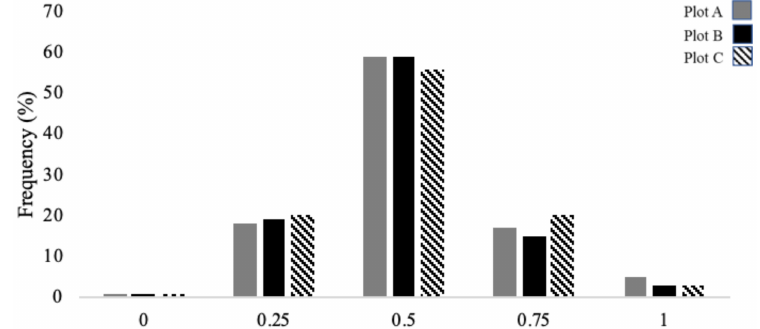
Figure 5. The very similar distributions of the uniform angle index in the three